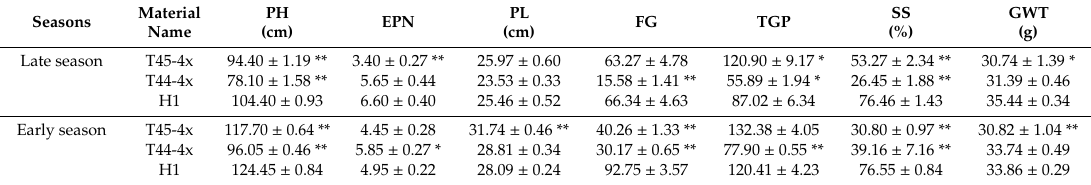
Figure 1. Breeding procedure and phenotype of Huaduo1 (H1) and its parents. ( A ) Breeding procedure of H1. ( B ) Morphologies of the whole plant of H1 and its two parents. ( C – E ) Grain size of H1 and its two parents. ( F – H ) Pollen grains stained with I 2 -KI in H1 and its two parents. ( I – K ) Comparison of the pollen fertility ( I ), seed set ratio ( J ), and plant height ( K ) between H1 and its two parents. Table 1. Genetic variation in agronomic traits of neo-tetraploid rice and its